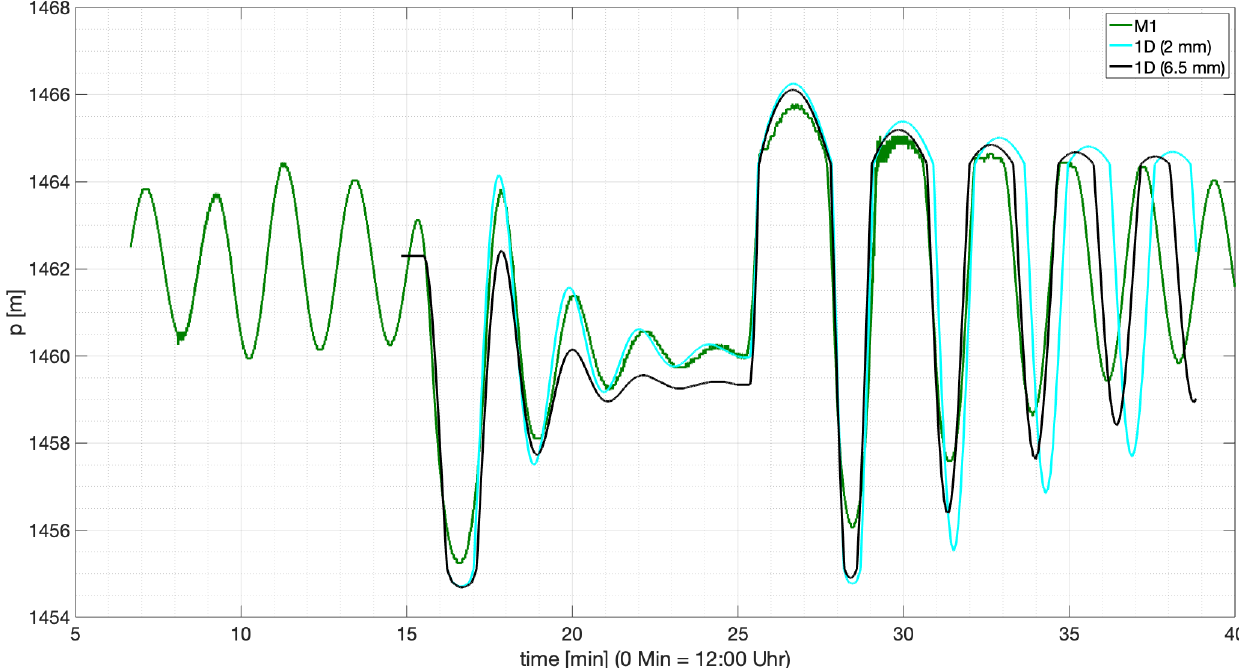
Figure 6. Comparison of the measurement of a starting and closing transient operation case compared with two exemplary 1D-numerical simulations with two different roughness value in the headrace